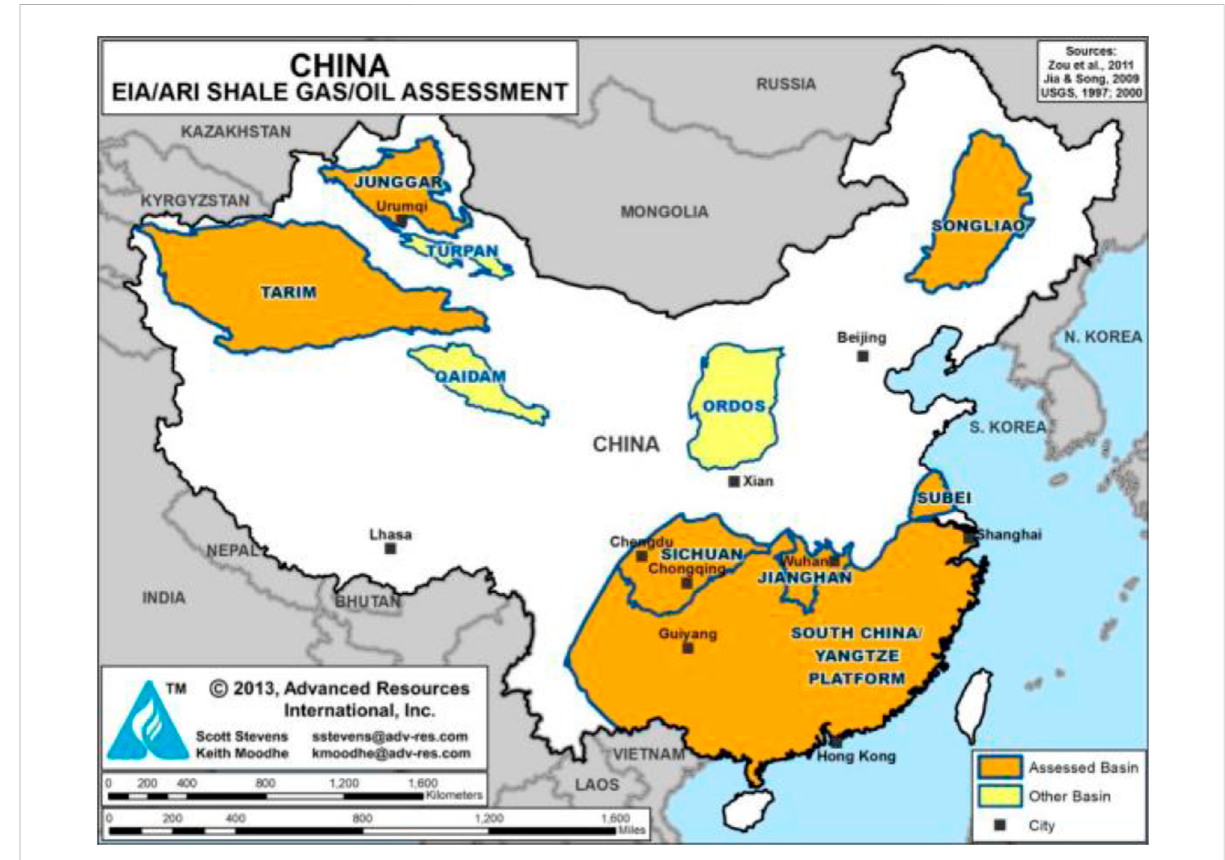
FIGURE 2 China ’ s most prospective shale gas basins [Source: U.S. Energy Information Administration (September